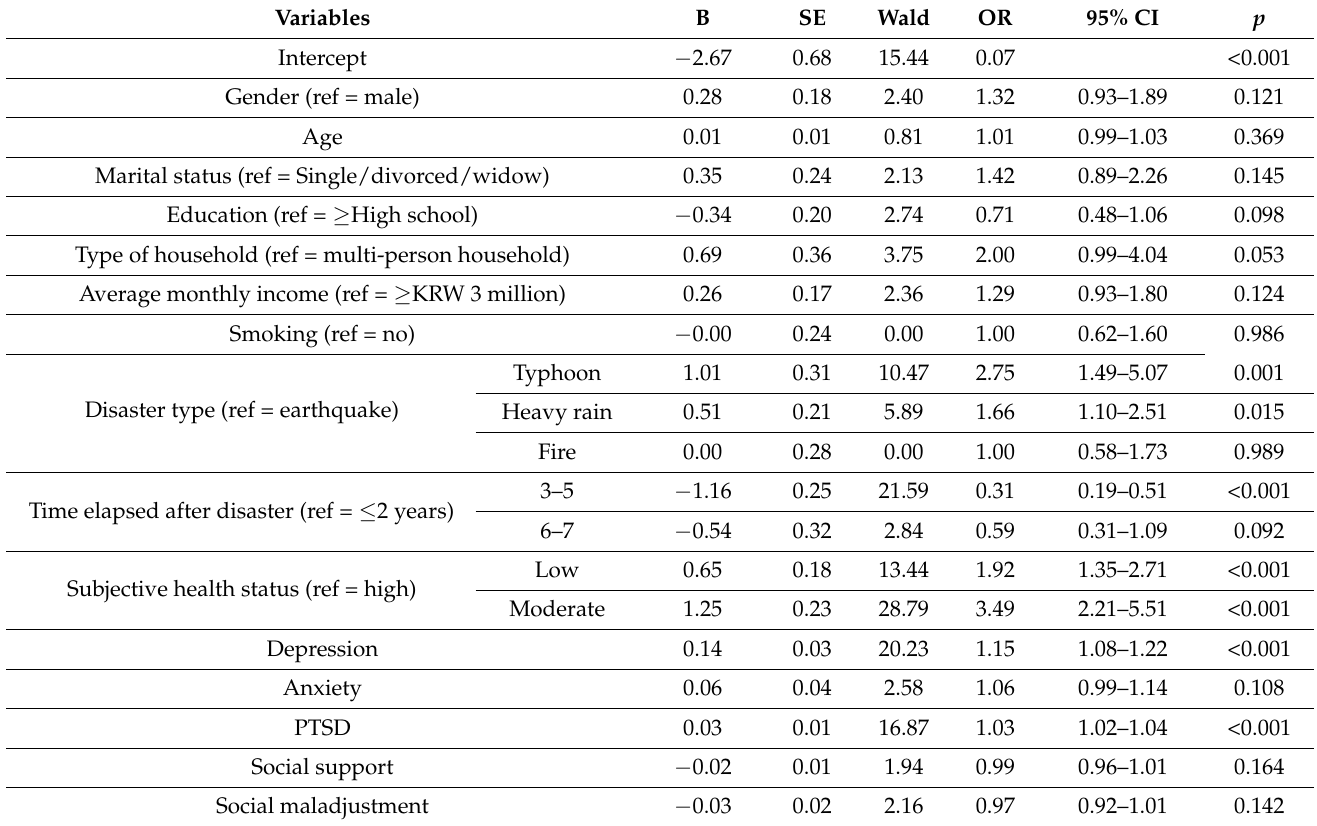
Table 3. Factors associated with subjective sleep quality.